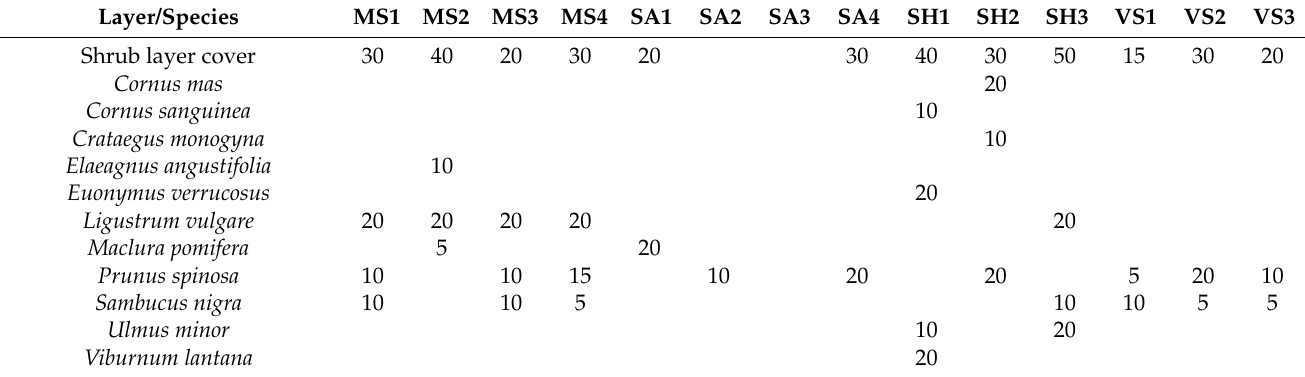
Table 4. Shrub species composition and cover values (%) in the examined